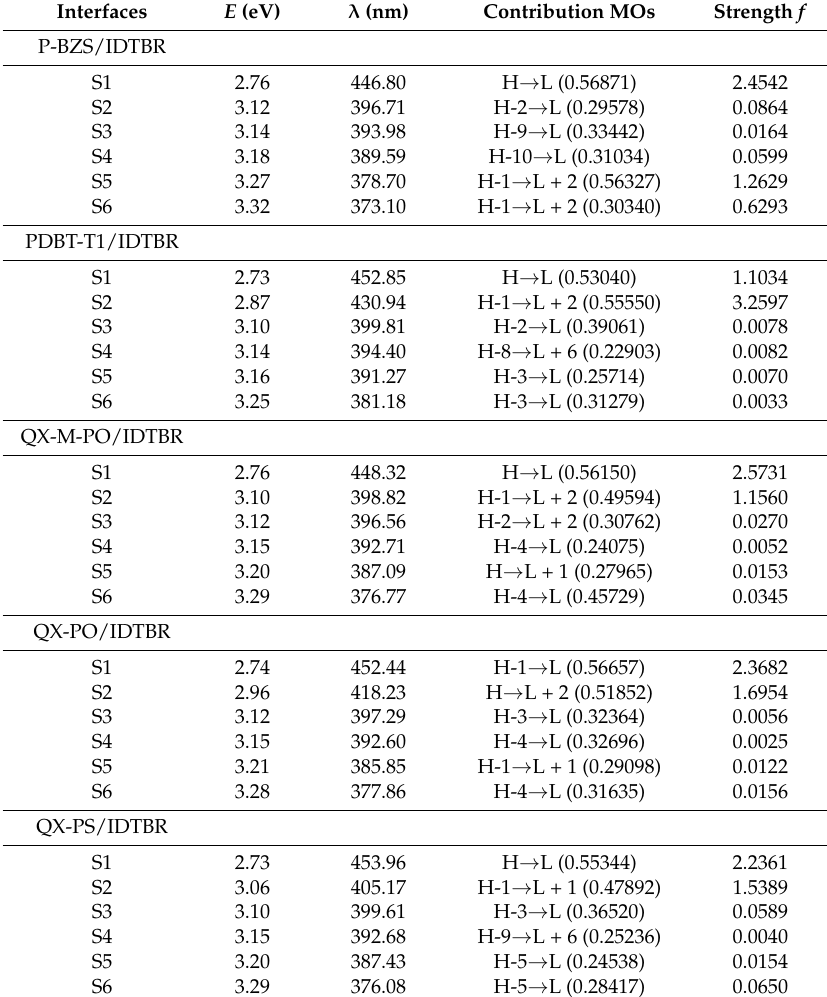
Table 11. Transition energies and oscillator strengths for D/A interfaces